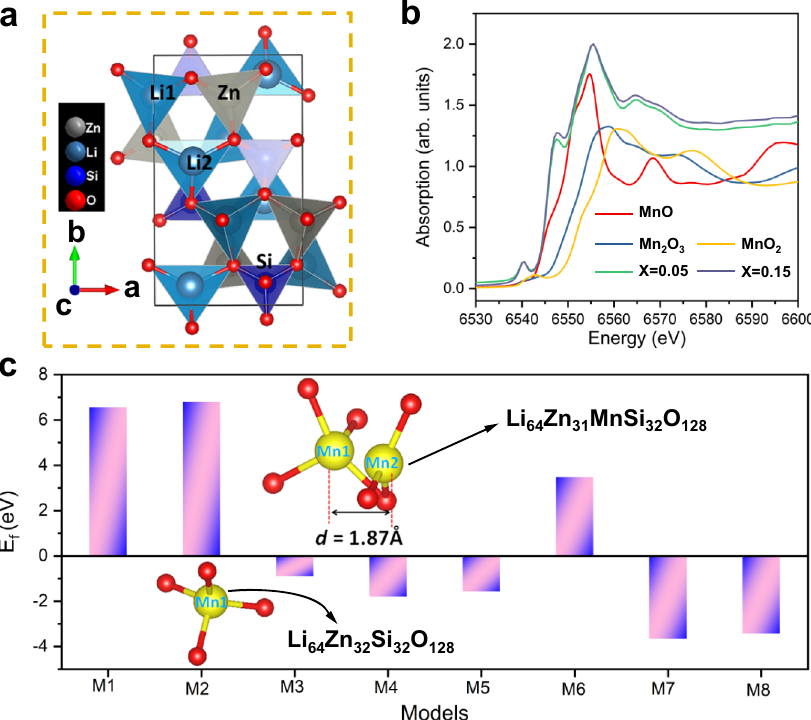
Fig. 1 Structural analyses of Mn doping in Li 2 ZnSiO 4 . a Crystal structure of Li 2 ZnSiO 4 . b The Mn K-edge XANES spectra of Li 2 Zn 0.95 SiO 4 :0.05Mn 2 + and Li 2 Zn 0.85 SiO 4 :0.15Mn 2 + and the reference compounds (MnO, Mn 2 O 3 and MnO 2 ). c Formation energy ( E f ) for different substitution models of Mn in